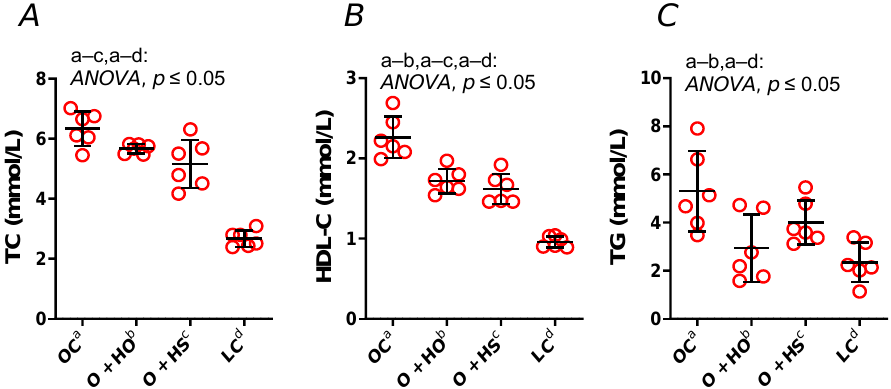
Figure 2. Total cholesterol (TC) ( A ), high-density lipoprotein cholesterol (HDL-C) ( B ), and triglyc- erides (TG) ( C ) in blood plasma of 8-week-old lean (LC) and obese (OC) Zucker rats fed a diet containing hemp seed oil (HO) and hemp seeds (HS) for a further 4 weeks. Values are means ± SD, n = 6, p ≤ 0.05 (two-way ANOVA). HO decreased the HDL and TG; meanwhile, HS decreased the HDL and TC.